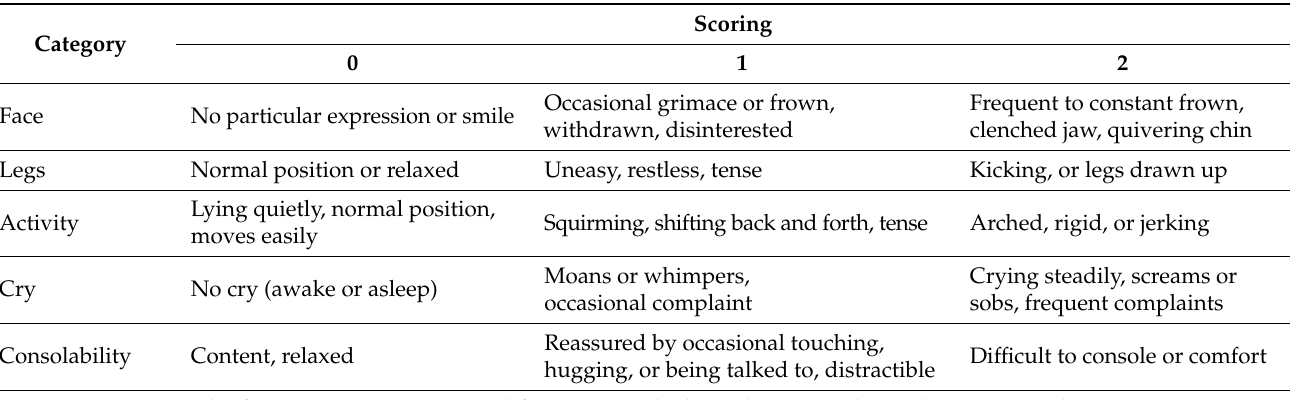
Table 1. Description of the scores for each category of the Face Legs Activity Cry Consolability (FLACC) scale for the behavioural assessment of pain